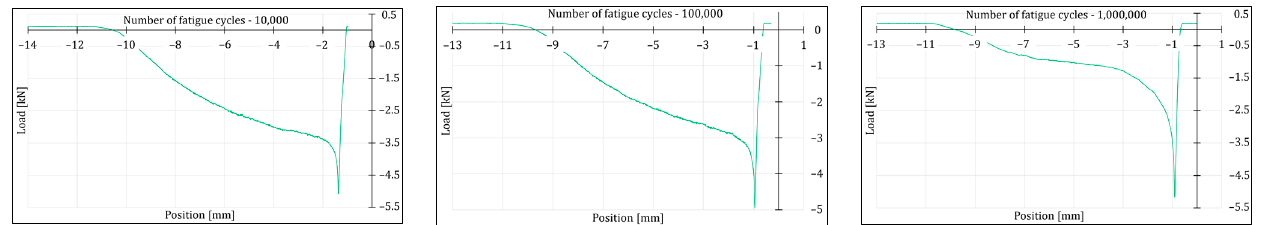
Figure 5. Shaft sleeve removal force pa tt ern after successive fatigue cycles.